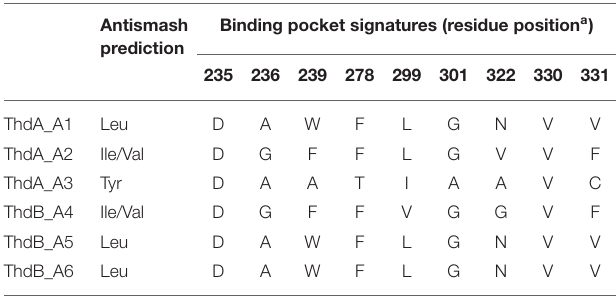
TABLE 2 | Signature motifs of adenylation domains from the Thd